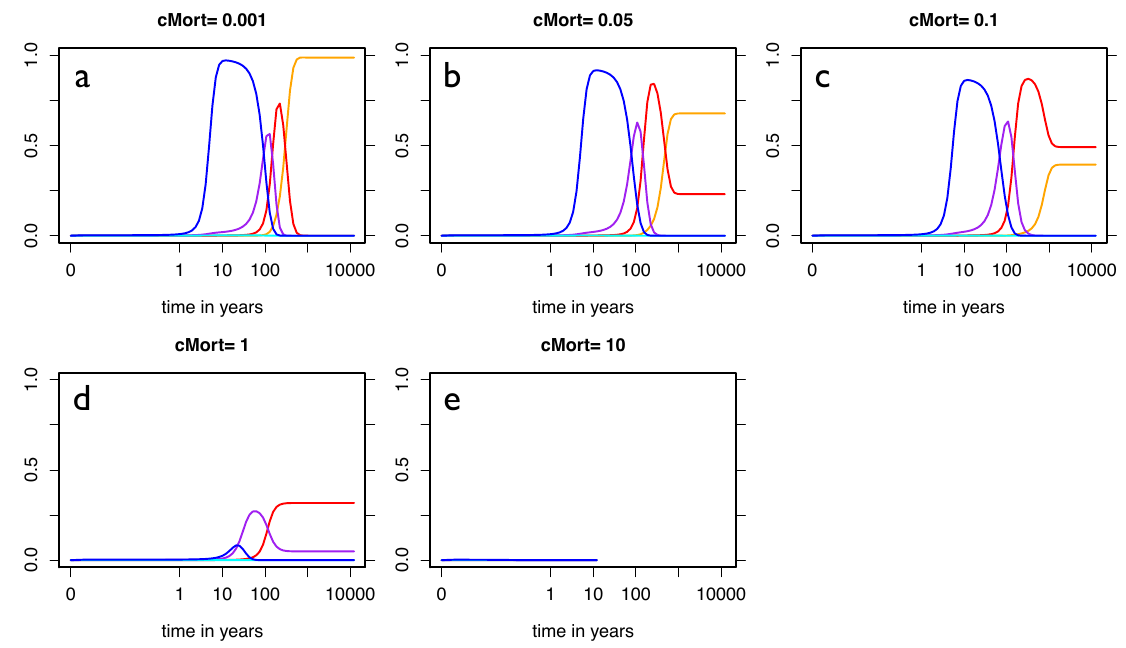
Fig. 6. Time-series of population dynamics under five increasing values for perturbations ( c Mort ) from (a) to (e) . The time in years is on logarithmic scale, the y-axis shows the relative abundance or occupied area of each PPS. Colours refer to coloured PPSs in Fig. 5. PPSs interact between seeds and for resources.